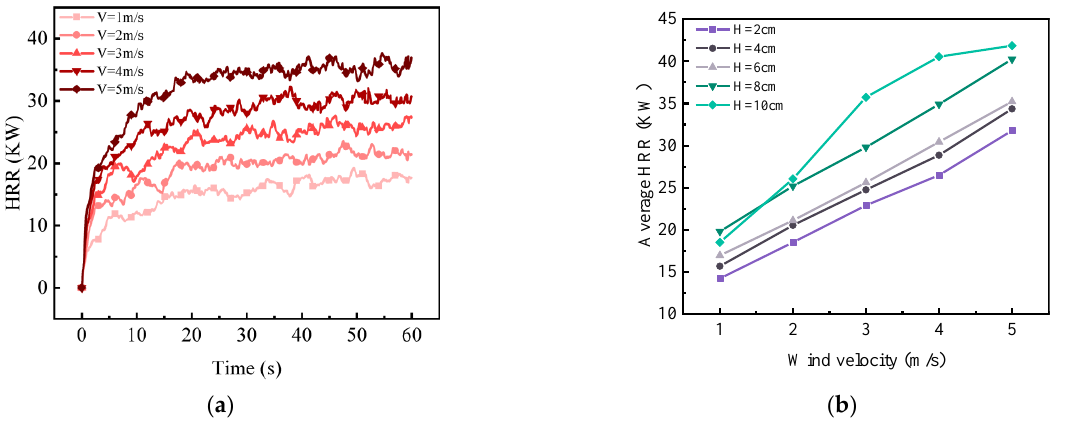
Figure 6. ( a ) Flow velocity vector field changes in the wind tunnel under different wind velocities (H = 6 cm) and ( b ) average HRR of the simulation scenarios.